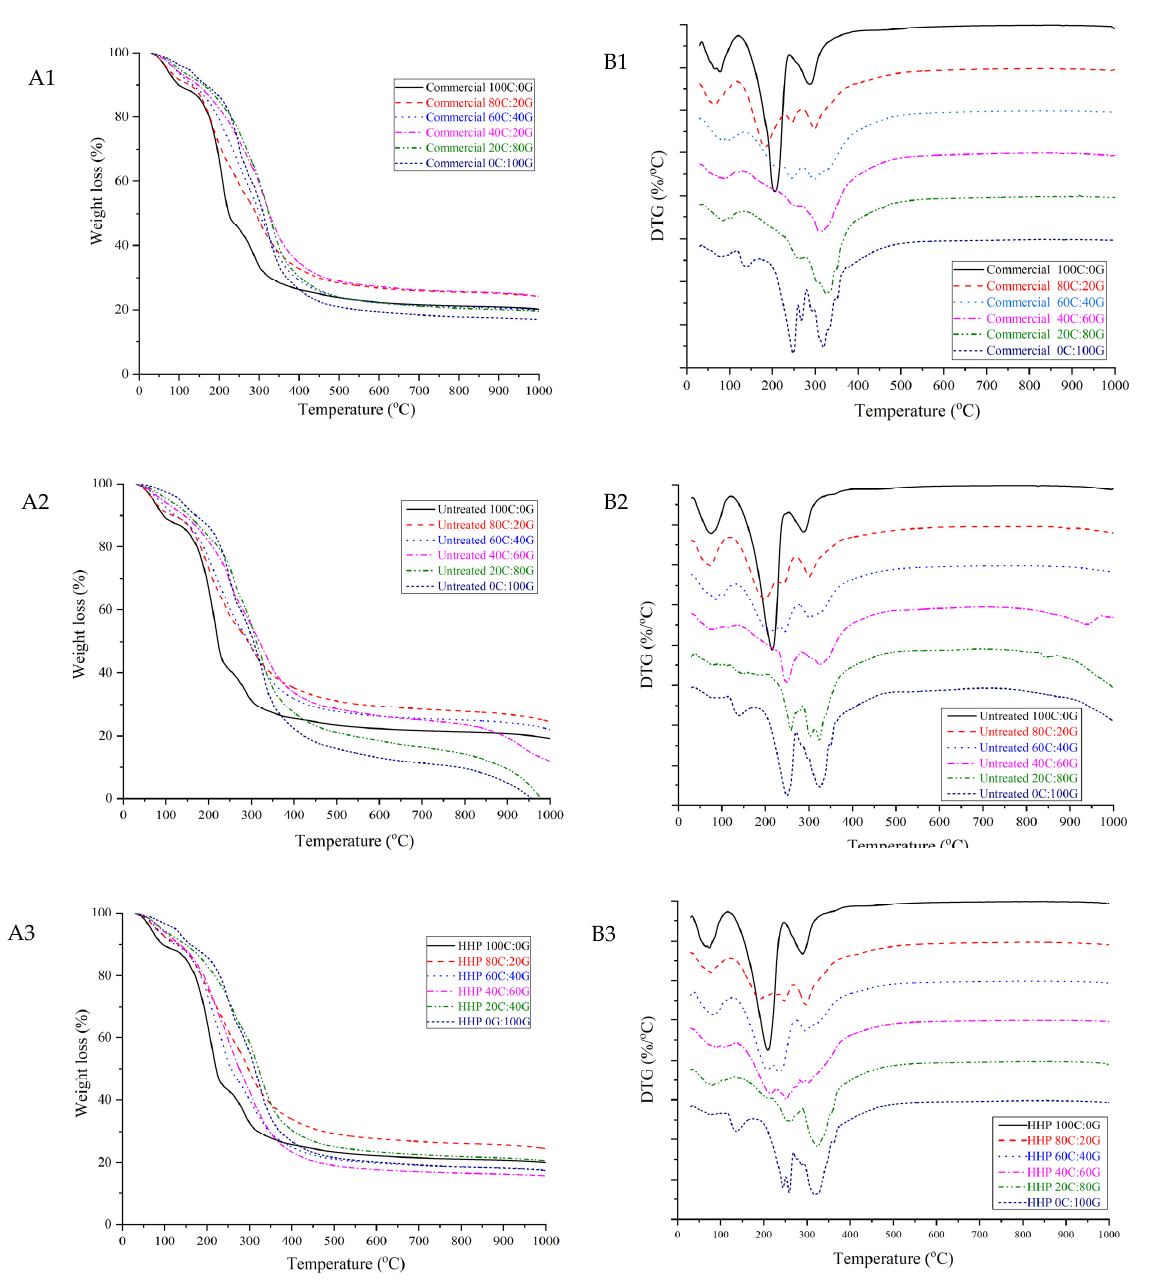
Figure 2. TGA curves of gelatin-based film incorporated with commercial chitosan ( A1 ), untreated chitosan ( A2 ), and HHP chitosan ( A3 ); DTG curves of gelatin-based film incorporated with commercial chitosan ( B1 ), untreated chitosan ( B2 ), and HHP chitosan ( B3 ).